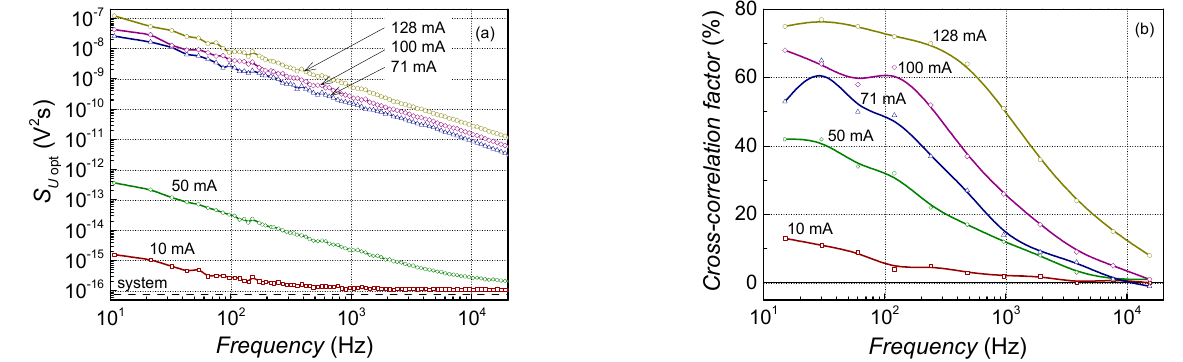
Figure 4. Typical electrical noise spectra of the investigated laser diodes at room temperature at small currents below the threshold ( a ) and at larger current region around and above the threshold ( b ) (sample No. 6: AlGaAs-based LD with single parabolic QW).